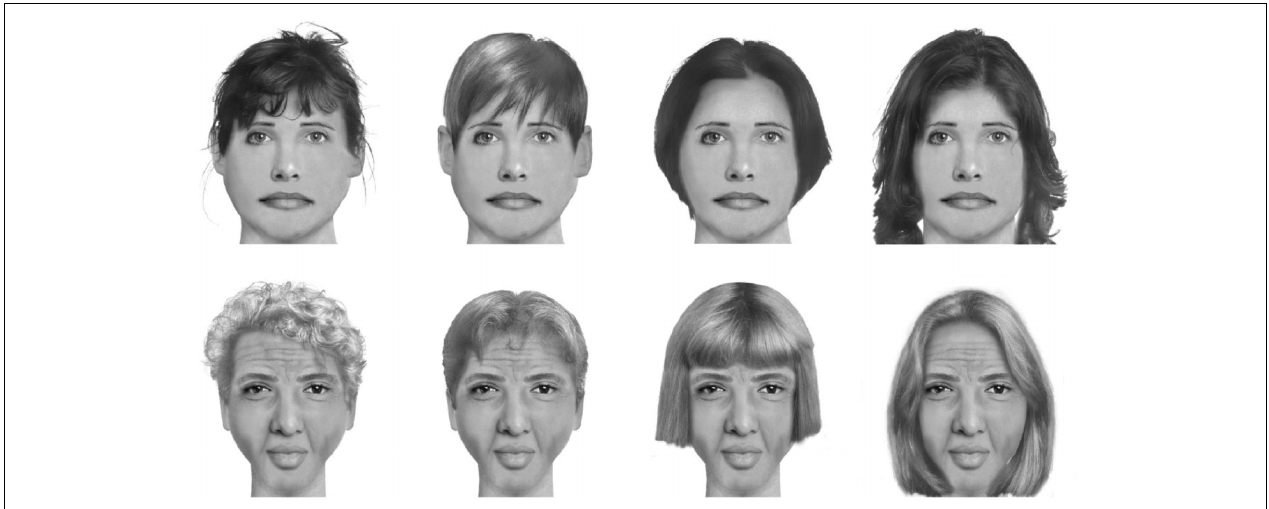
FIGURE 1 | Examples of stimuli – (top row from left to right): younger stimuli with hair put up, short, medium, and long hair; (bottom row from left to right): older stimuli with short and curly hair, short and straight hair, medium and long hair.